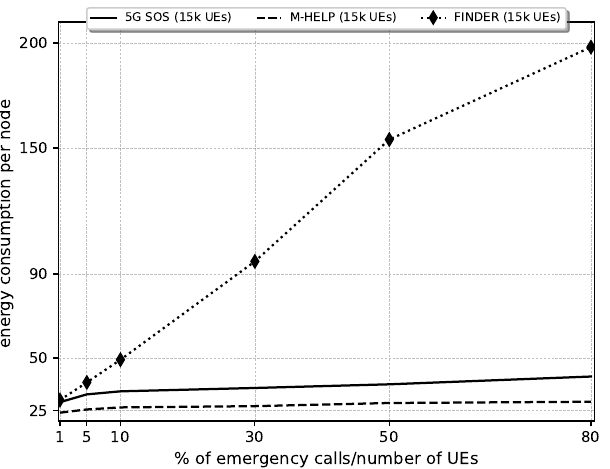
Figure 17. Comparison of the energy consumption per node against the ratio of the number of emer-